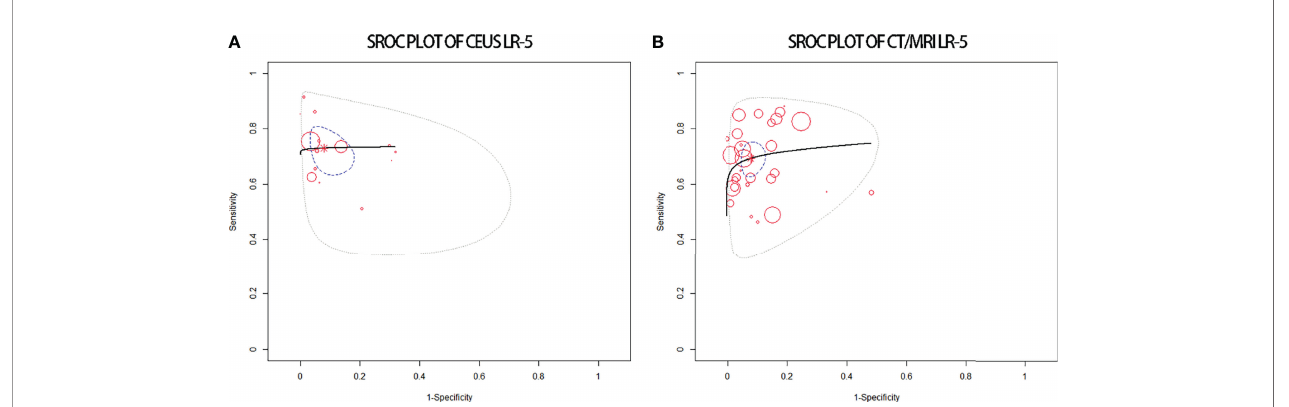
FIGURE 5 | sROC plots of CEUS LR-5 (A) and of CT/MRI LR-5 (B) for the diagnosis